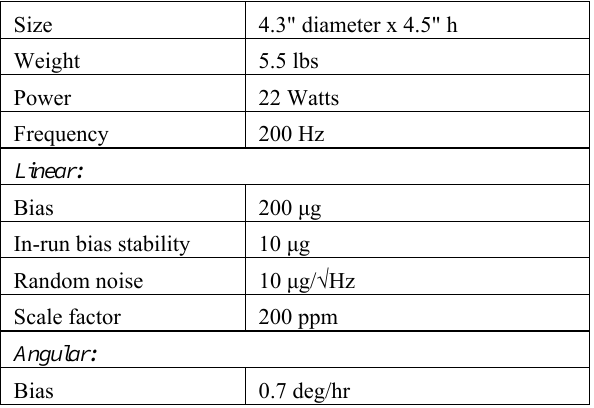
Table 4: DMARS-I IMU